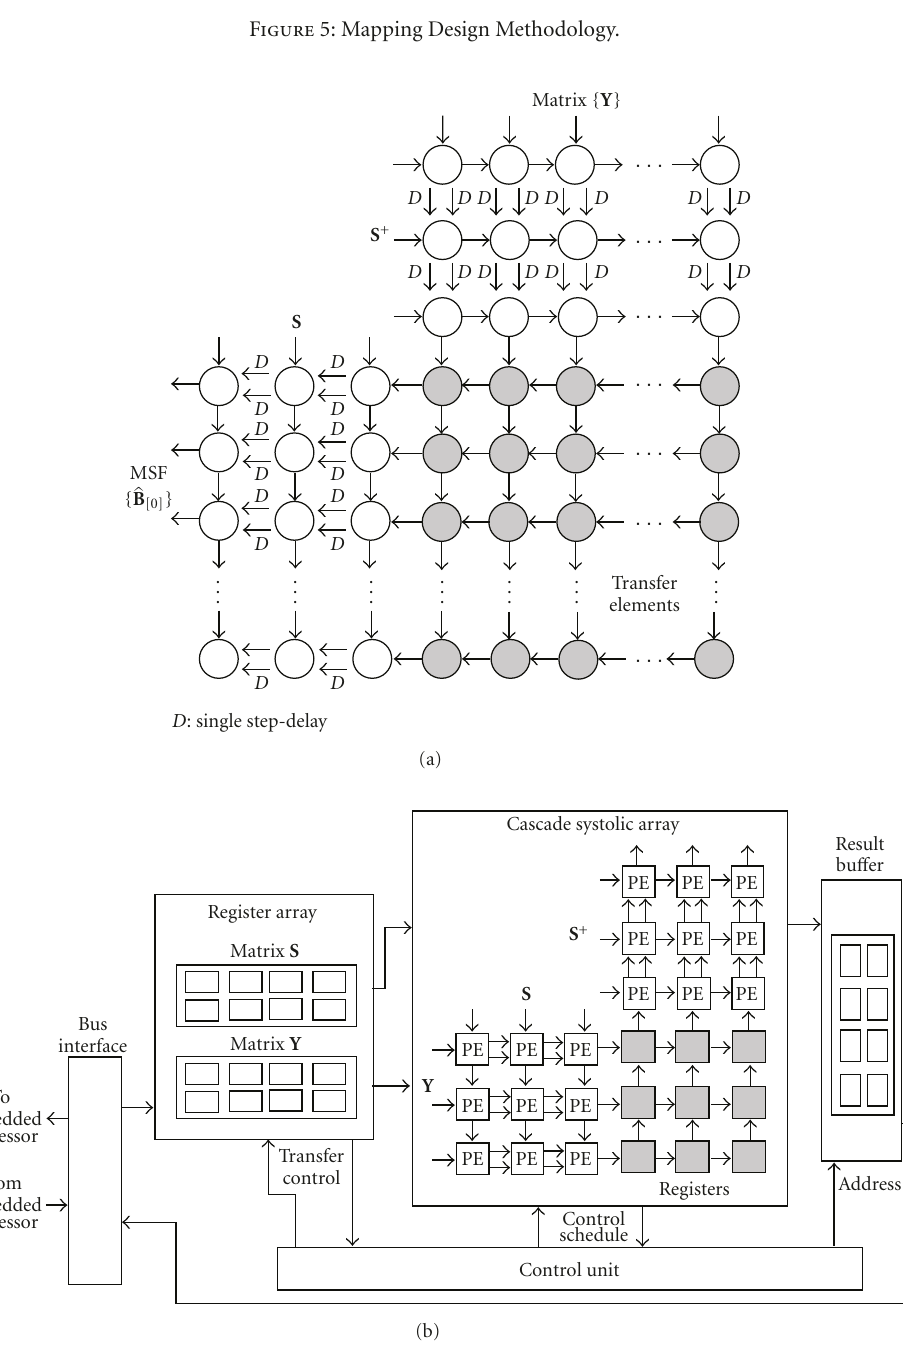
Figure 6: MSF implementation: (a) cascade systolic array for performing the MSF function; (b) MSF systolic